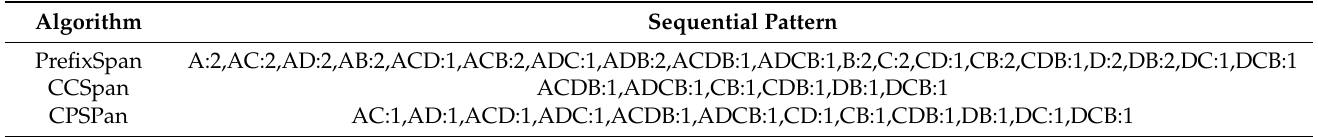
Table 1. Comparison of sequential pattern mining results. Algorithm Sequential